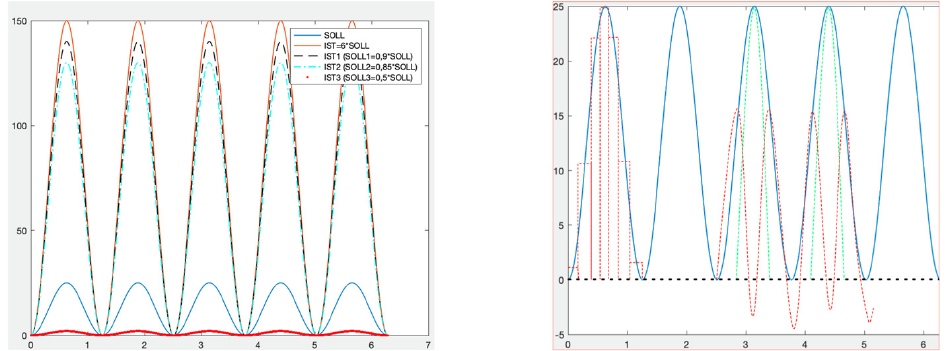
Figure 13. Voltage reduction during resonance versus modulation techniques effective for specific intervals of system state.